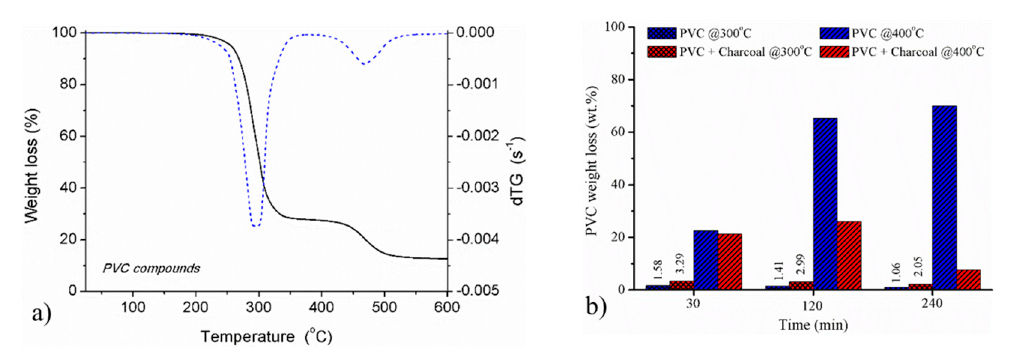
Figure 1. ( a ) TGA curve (solid line) and first derivative of the TGA curve (dashed line) of PVC compound, ( b ) PVC weight-loss percentage with/without heating-media (charcoal) using stepwise- pyrolysis at 300 °C and 400 °C.